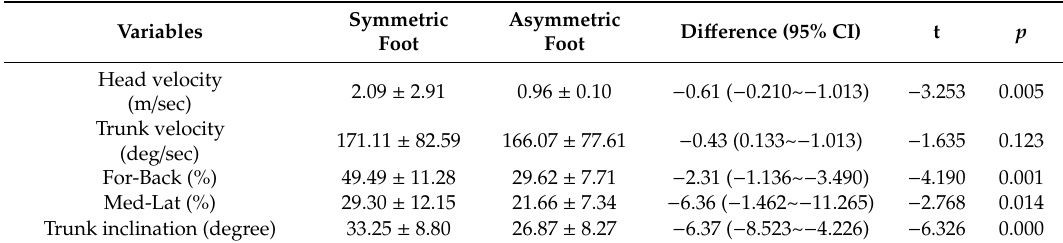
Table 3. Comparison of kinematics between symmetric and asymmetric foot